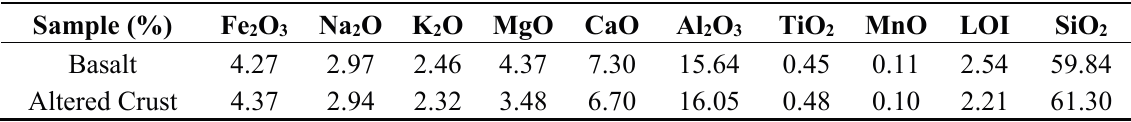
Table 2. Chemical compositions of basalt samples and the weathered zone (average). LOI: Loss on